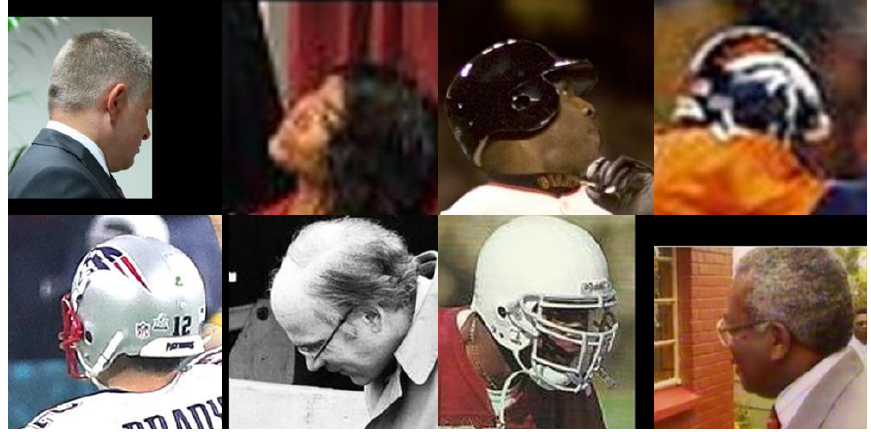
Figure 6. Examples of the occlusions found in the faces not included. Table 6. Verification performance over the five intervals using the CPLFW [13] dataset. Intervals # of Pairs MobileFaceNet (%) EfficientNet-B0 (%) GhostNet